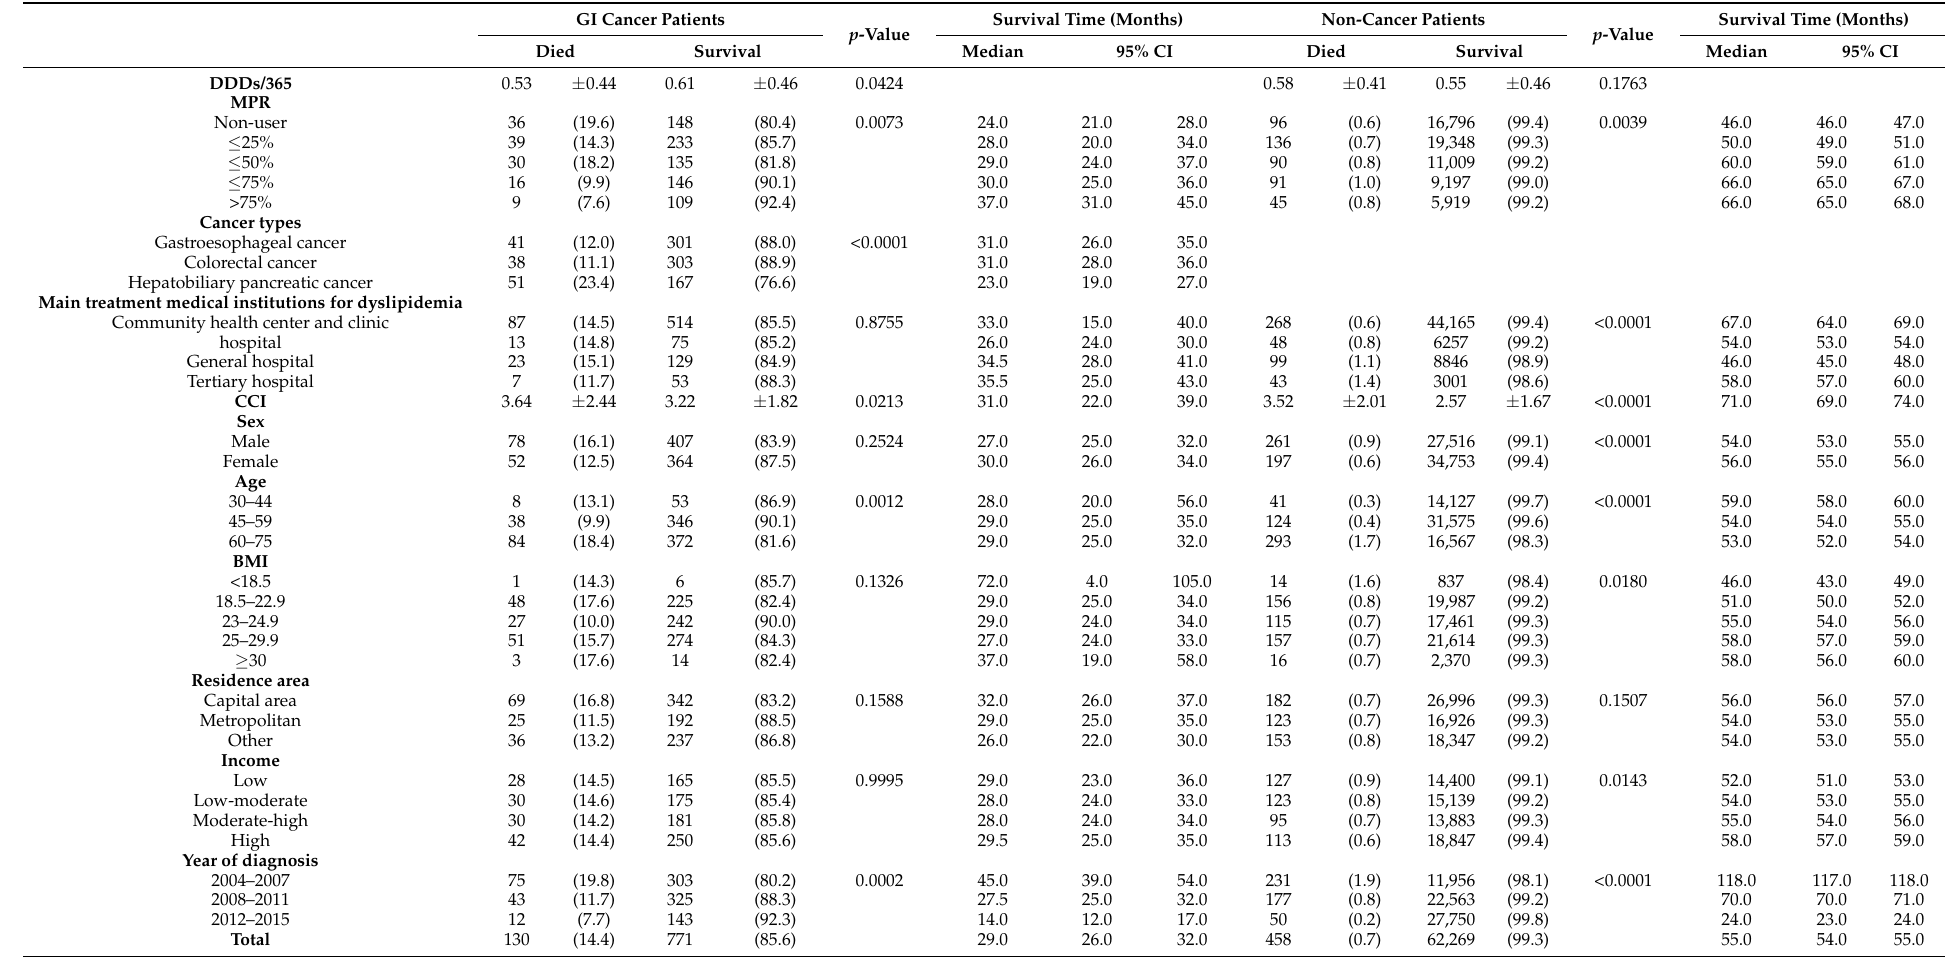
Table 1. Association between continued statin use and mortality after diagnosis in dyslipidemia and GI cancer patients (Unit: N/M, %